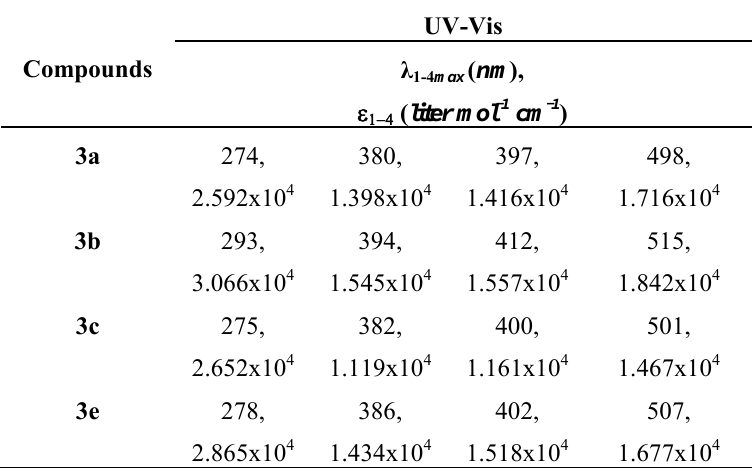
Table 1: UV-Vis spectral data of 3